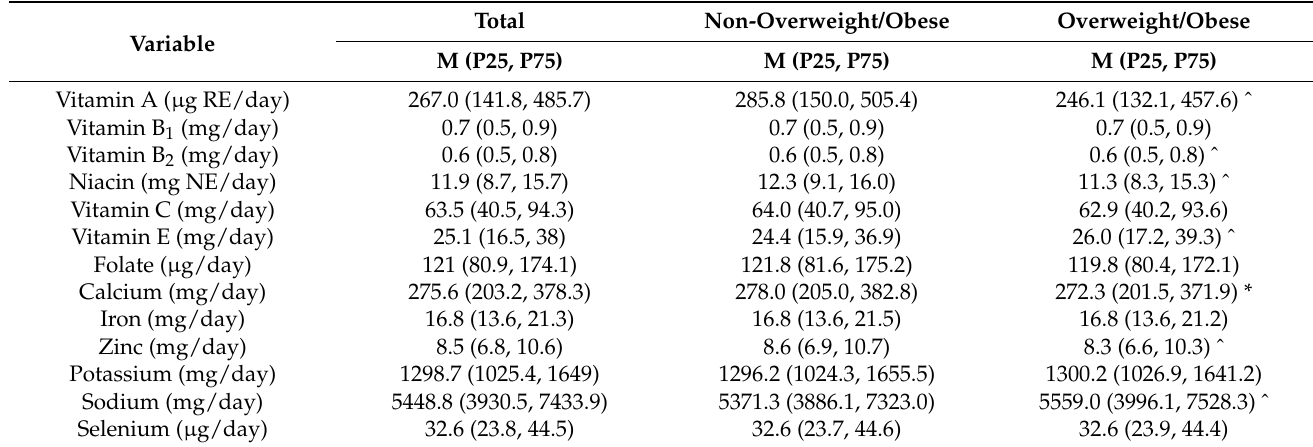
Table 2. Median intake of major vitamins and minerals in non-pregnant and non-lactating women aged 18–49 years (g/day) [M (P25,